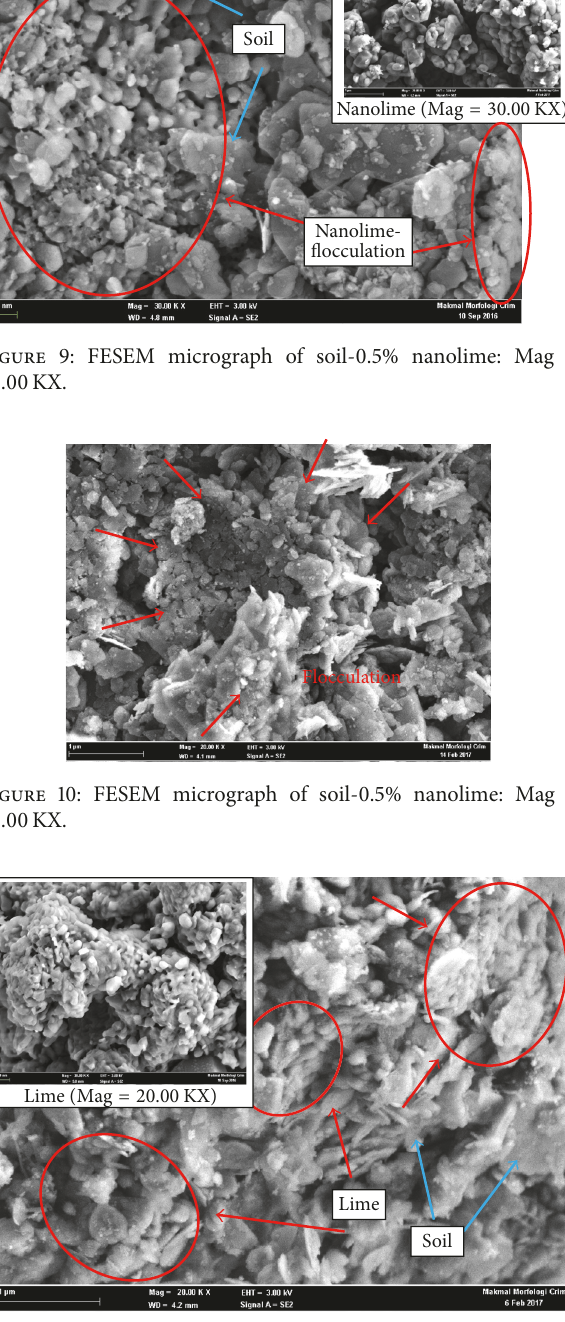
Figure 11: FESEM micrograph of soil-1% lime: Mag = 20.00 KX.